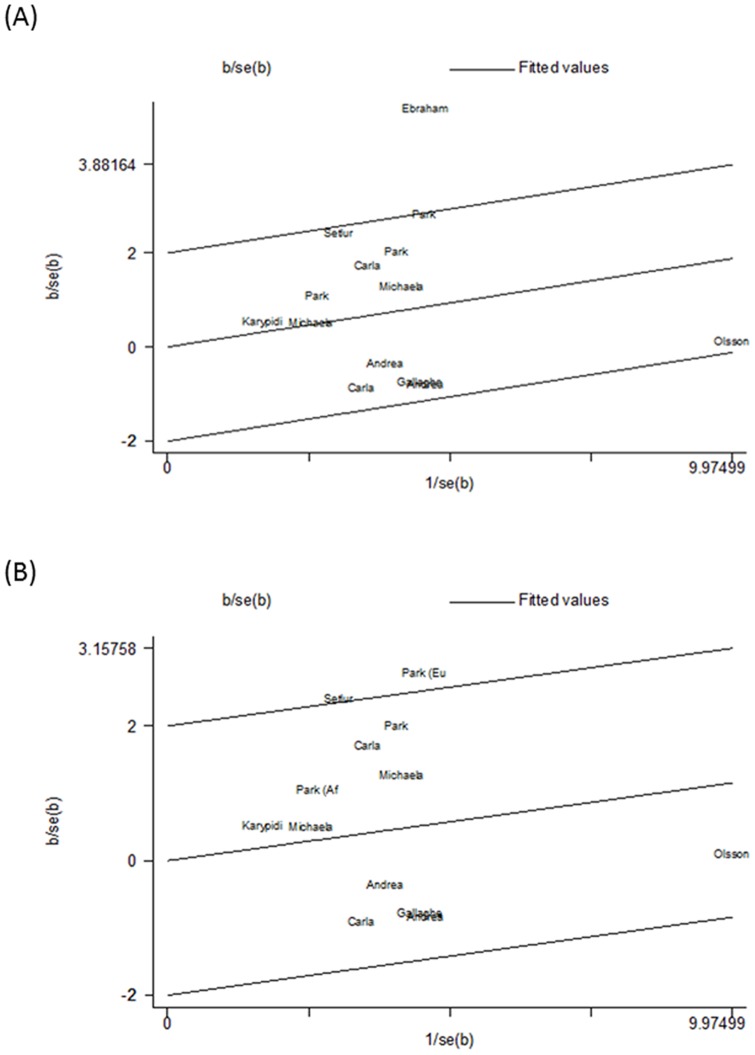
Galbraith radial plot for Del/Del versus Ins/Ins+Ins/Del.(A). The figure shows the contribution of individual studies to the heterogeneity and a study by Ebraham et al was found to be the cause of the heterogeneity. (B). After the exclusion of the study by Ebraham et al, the result of the contribution of individual studies to the heterogeneity.